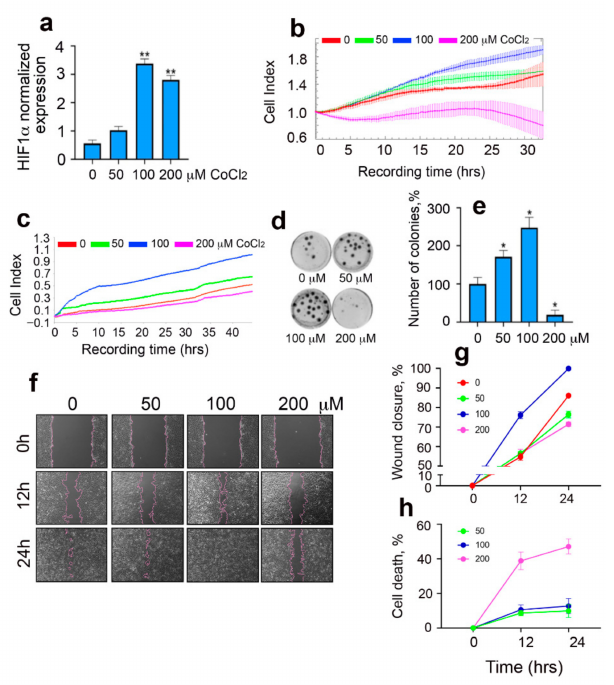
Figure 1. CoCl 2 affects the proliferation, migration, and colony formation of rat glioma cells in a hypoxic model. ( a ) The data of RT-PCR are presented. Histogram bars show the relative amount of mRNA transcribed from the hif1 α gene in C6 cells 6 h after addition of CoCl 2 ; the data are normalized to the amount of actin mRNA. ( b ) Cell index data were obtained using the xCELLigence device. The graph shows the dynamics of the C6 cellular index placed in E-plates; CoCl 2 was added in concentrations of 50, 100, and 200 µ M after cell attachment to the bottom; incubation time is indicated on the x -axis. Representative data from three independent experiments are shown. ( c ) Data on C6 cell motility data obtained using the xCELLigence system. The graph shows the dynamics of the cellular index measured in the upper wells of the Cell Invasion and Migration (CIM) plates of the xCELLigence system in a medium containing 50, 100, or 200 µ M CoCl 2 . The lower chambers of the CIM plates were filled with CoCl 2 -free medium. The recording of cell migration through the microporous membrane of the CIM plates lasted 40 h. Representative data from three independent experiments are shown. ( d ) C6 cell colony formation efficacy in the presence of 50, 100, and 200 µ M CoCl 2 . ( e ) The result of colony number quantification from section ( c ) is presented. The histogram bars show the average normalized number of colonies based on three independent experiments. ( f , g ) Wound healing assay was performed with the aid of the JuLI Stage microscope and monitored by JuLI software. Cells were cultivated for 24 h in the presence of CoCl 2 in different concentrations before the monolayer was scratched. The wound healing was detected with microscopy ( f ) and quantified with the aid of JuLI software ( g ). ( h ) The results of the CytoTox96 assay. C6 cells were incubated with CoCl 2 for 24 h. Data presented as mean ± standard error of mean (SEM). Statistical significance is indicated as * p < 0.05 and ** p <